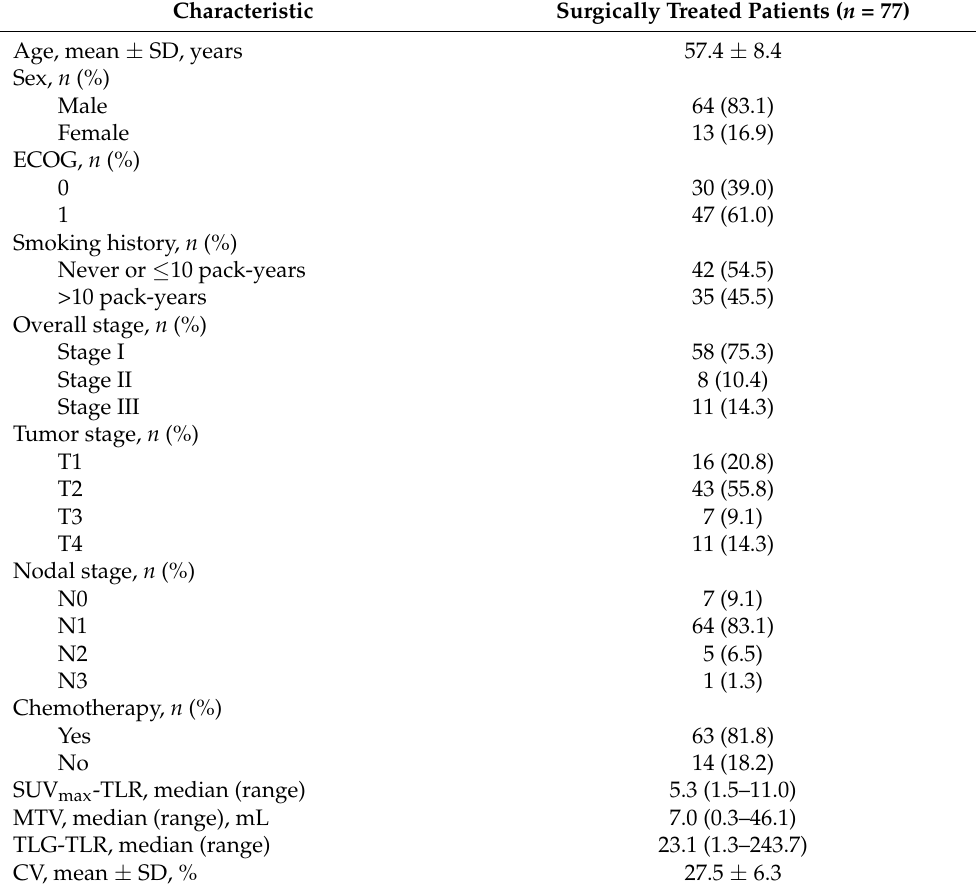
Table 4. Patient characteristics for patients who received surgery as the primary treatment.